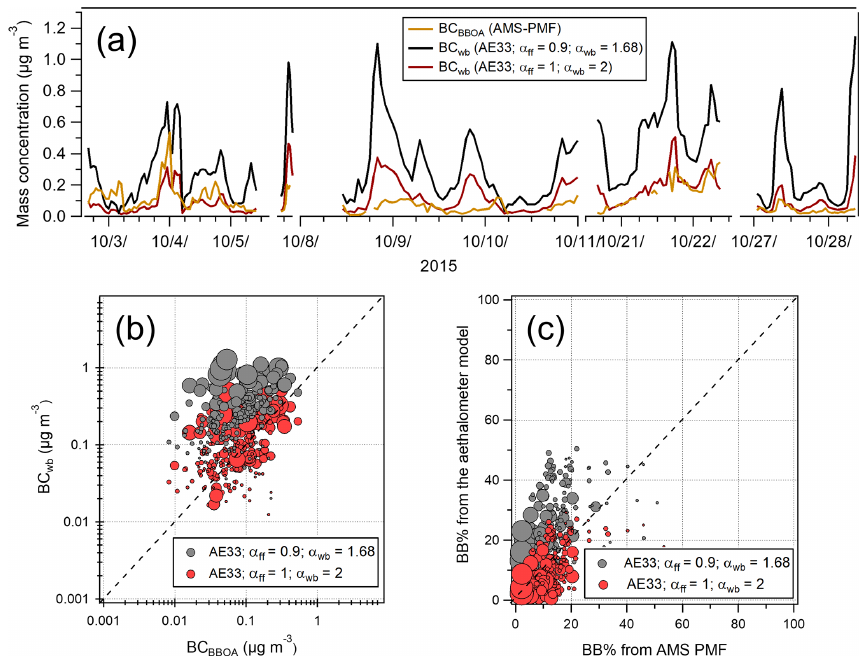
Figure 8. Comparison of AMS-PMF with the Aethalometer model source apportionment for BC in the street canyon. Time series (a) , the scatter plot of BC wb and BC BBOA concentrations (b) , and BB% (c) . BB% with the Aethalometer model was calculated by using α ff = 0 . 9 and α wb = 1 . 68 and α ff = 1 and α wb = 2. We used 1h time resolution. The marker size in (b) and (c) illustrates the concentration of total BC. The dotted line in (b) and (c) shows the 1 : 1